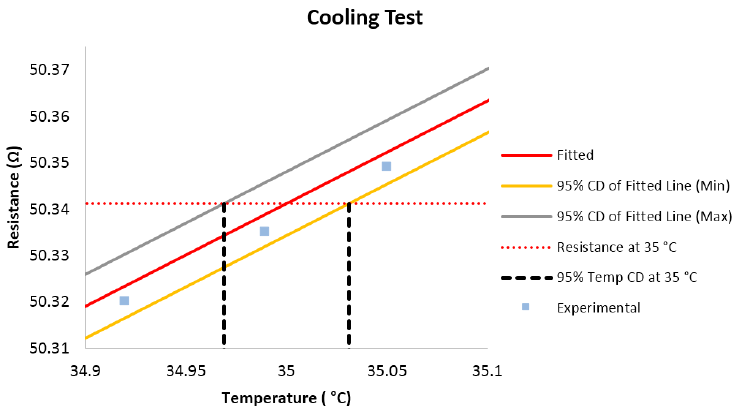
Figure 13. Uncertainty in TR relationship at 35 °C (Cooling, N10046S1).